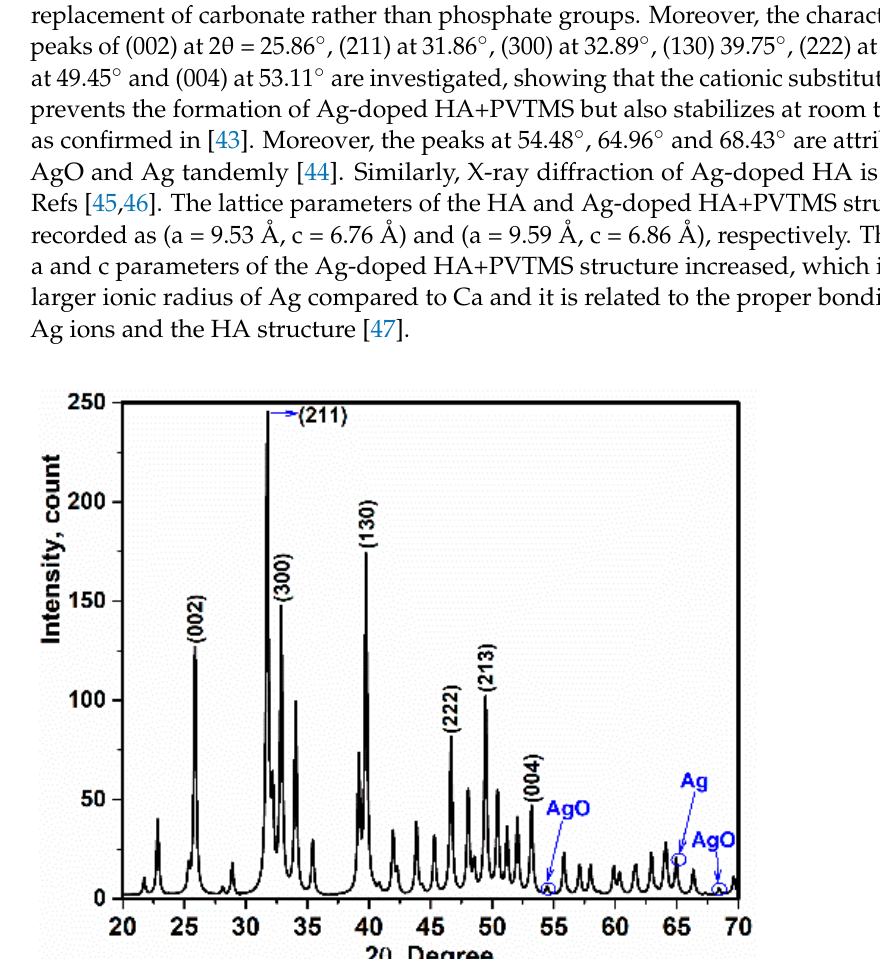
( b ) Figure 7. ( a ) Linear plots of the Monshi-Scherrer equation and ( b ) TEM image of scaffold. 3.3. Fourier-Transform Infrared Spectroscopy (FTIR) Analysis The FTIR spectrum of the Ag-doped HA+PVTMS scaffold is shown in Figure 8. This spectrum corresponds with FTIR spectra of HA [52,53]. Moreover, the strong stretching mode is associated with PO (cid:2872)(cid:2871)(cid:2879) at 1049 cm − 1 and the broad spectrum is due to the bonding between O and H. The evidence of the existence of carbonate groups in HA corresponds